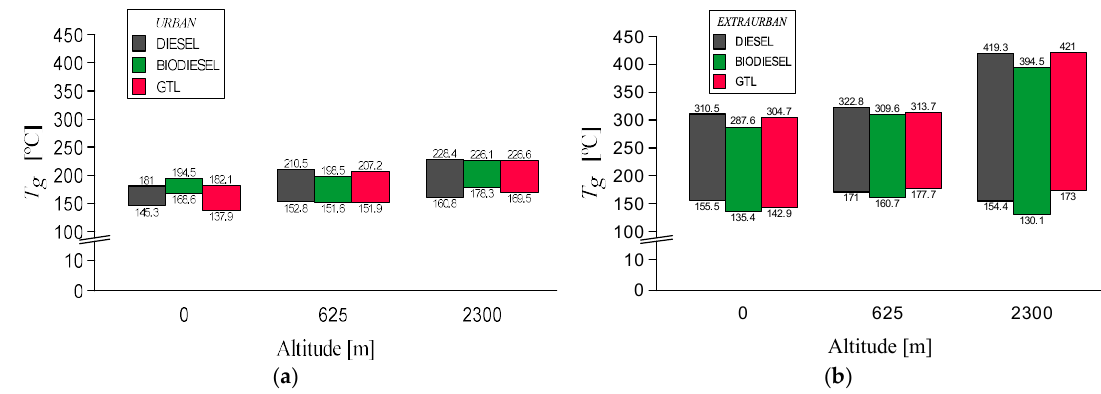
Figure 6. Measured exhaust gas temperature range at the outlet of the diesel particle filter (DPF): ( a ) Urban driving conditions, ( b ) Extra-urban driving conditions.